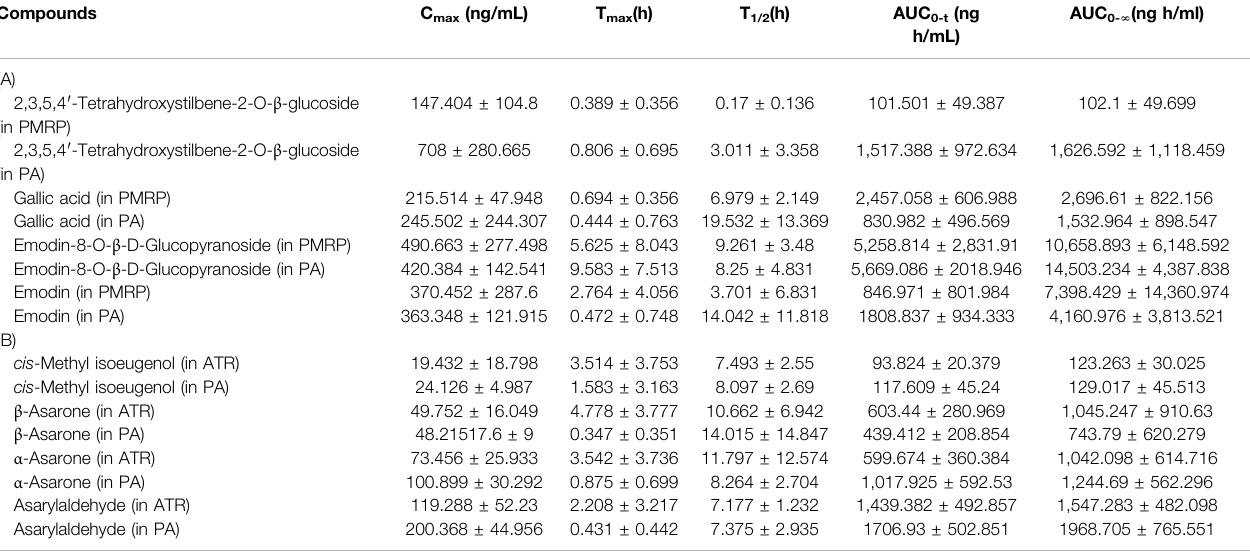
TABLE 1 | Pharmacokinetic parameters in rats following administration of PMRP, ATR, and PA Data represent mean ± S.D. ( n (cid:1) 6). Compounds C max (ng/mL) T max